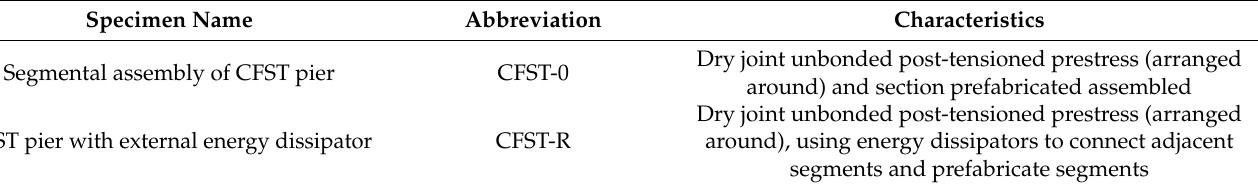
Table 1. Specimen name and characteristics.